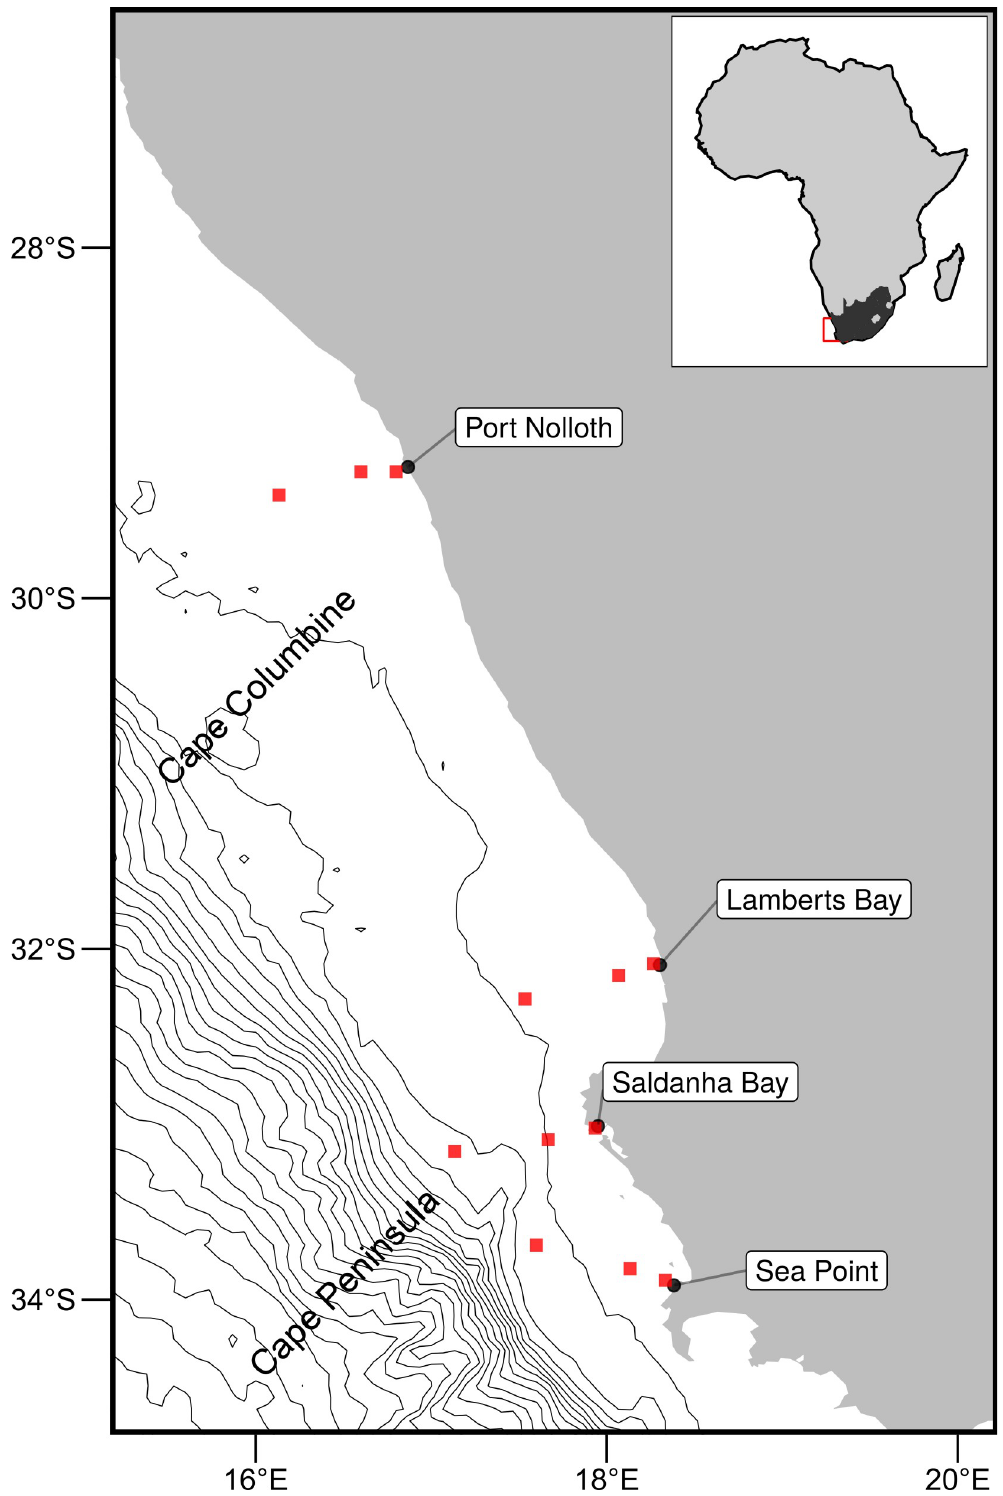
Fig 1. Map of the western portion of southern Africa showing the coastal bathymetry of the southern BUS. The black points represent the location of the in situ temperature recorders, and the red boxes show the pixels used along the shore normal transect from the satellite sea surface temperatures (SST) time series. The red boxes are at 0 km, 25 km and 50 km from the shoreline. https://doi.org/10.1371/journal.pone.0254026.g001 PLOS ONE | https://doi.org/10.1371/journal.pone.0254026 July 8,